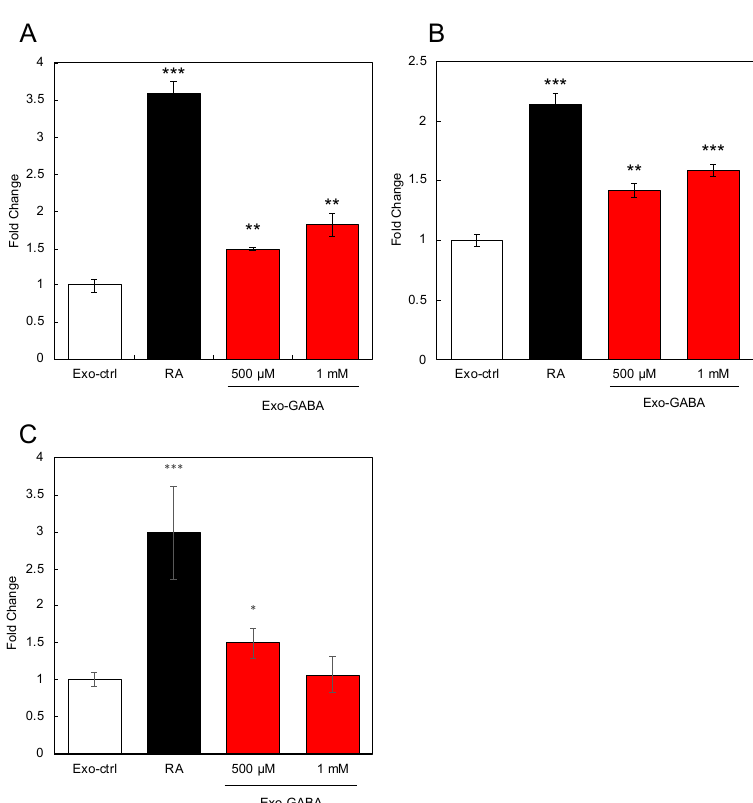
Figure 2. Effects of exosomes derived from GABA-treated Caco-2 cells on gene expression. Expression of brain-derived growth factor ( BDNF ) ( A ), Nestin ( B ), and neurofilament medium chain ( NEFM ) ( C ) in SH-SY5Y cells treated with exosomes derived from GABA-treated Caco-2 cells was evaluated by RT-qPCR. Retinoic acid (RA) was used as positive control. Multiple comparisons between groups were carried out by one-way ANOVA with Tukey’s post-hoc test. Statistical difference was evaluated by comparing to Exo-ctrl. Statistical significance was defined as p < 0.05 (* p < 0.05; ** p < 0.01; *** p < 0.001) (value means ± SEM, n = 3).